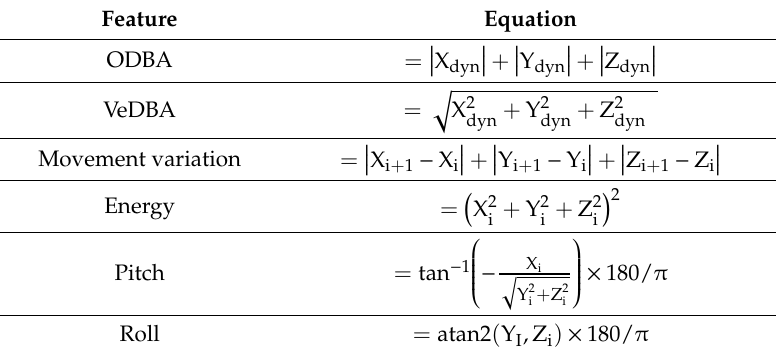
Table 2. Equations for six features used to calculate summary statistics for behaviour